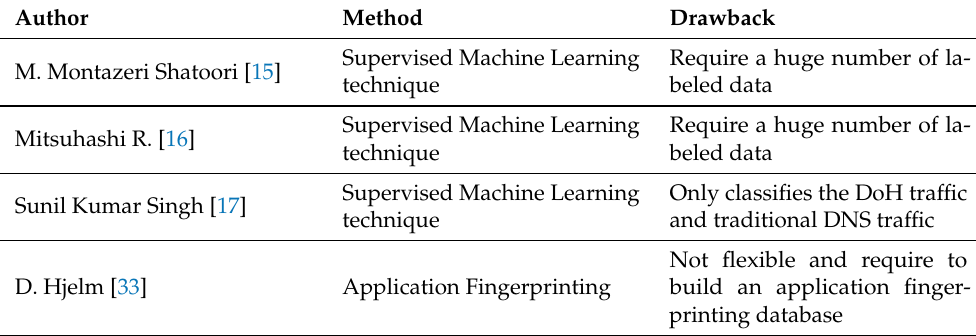
Table 1. The drawbacks of previous DoH detection